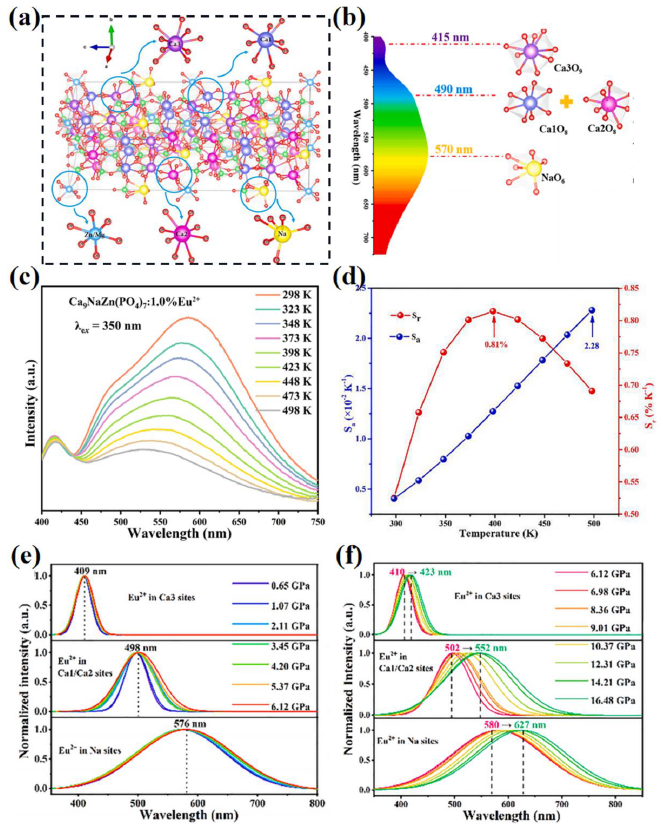
Figure 15. ( a ) Crystal structure of the Ca 9 NaZn(PO 4 ) 7 . ( b ) PL spectrum corresponding to different cationic sites of Ca 9 NaZn(PO 4 ) 7 :1.0%Eu 2+ phosphor excited by 350 nm. ( c ) Temperature-dependent PL spectra, ( d ) the calculated plots of absolute sensitivity (S a ) and relative sensitivity (S r ) versus temperature, ( e , f ) normalized Gaussian fitting PL spectra for Eu 2+ ions at different cation sites under different pressure of Ca 9 NaZn(PO 4 ) 7 :1.0%Eu 2+ phosphor. Reprinted with permission from ref. [105]. Copyright 2021 Elsevier B.V.